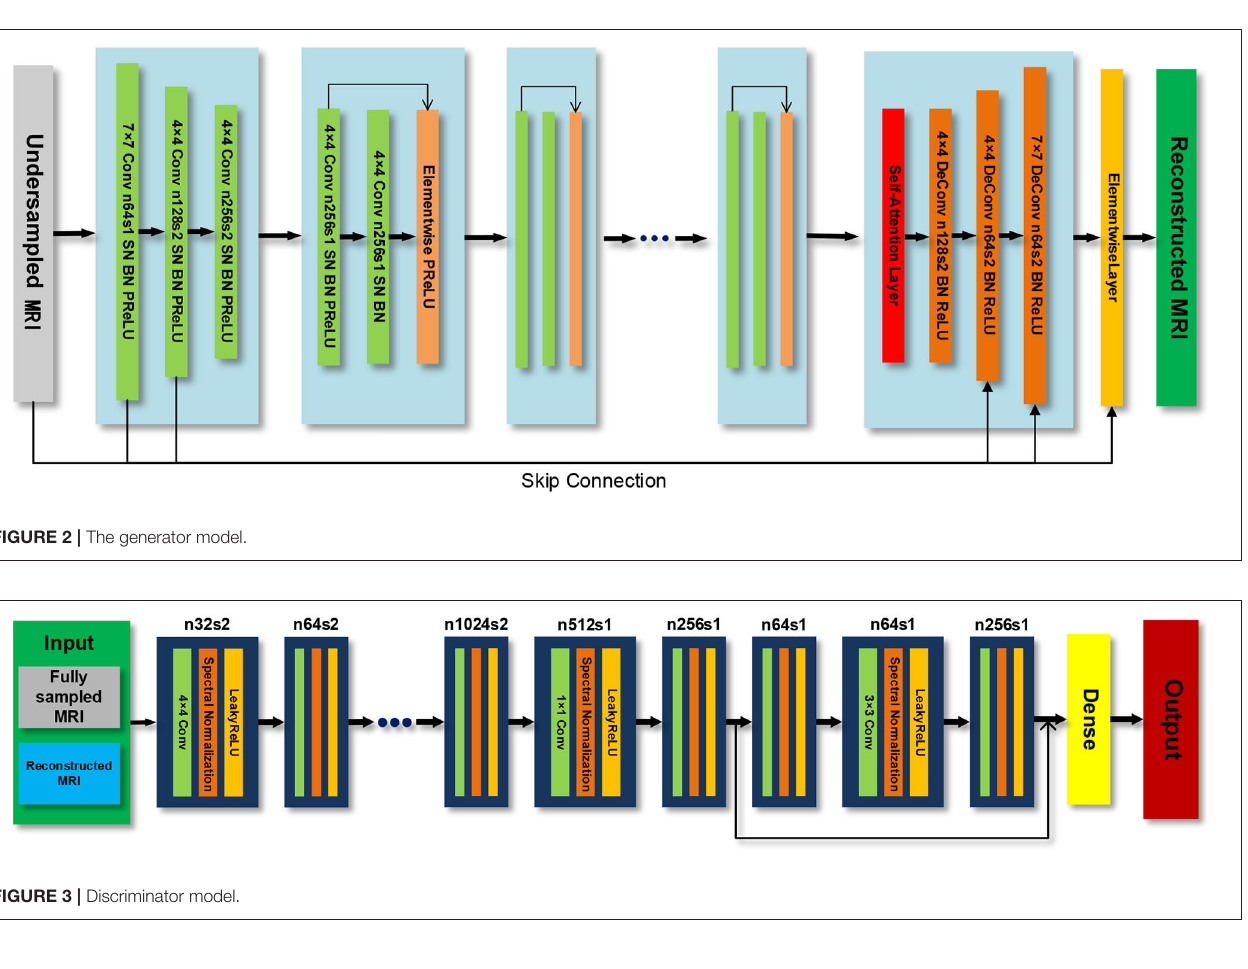
Figure 2 . In the self-attention module, the output feature map of the last residual block x with the channel number C of the previous convolution layer is input to three convolution layers with a kernel of 1 × 1 and the channel numbers of C / 8, C / 8 and C respectively, to obtain the feature space f ( x ), g ( x ) and h ( x